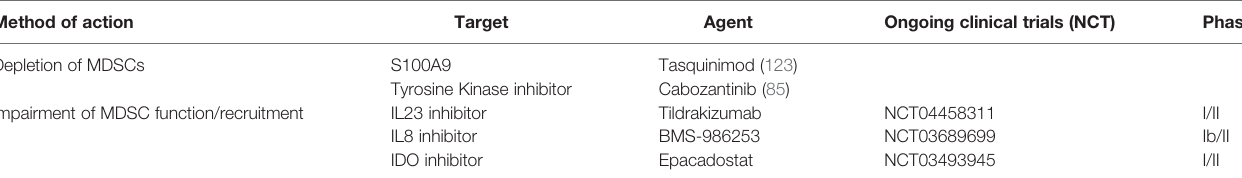
TABLE 2 | MDSC-directed